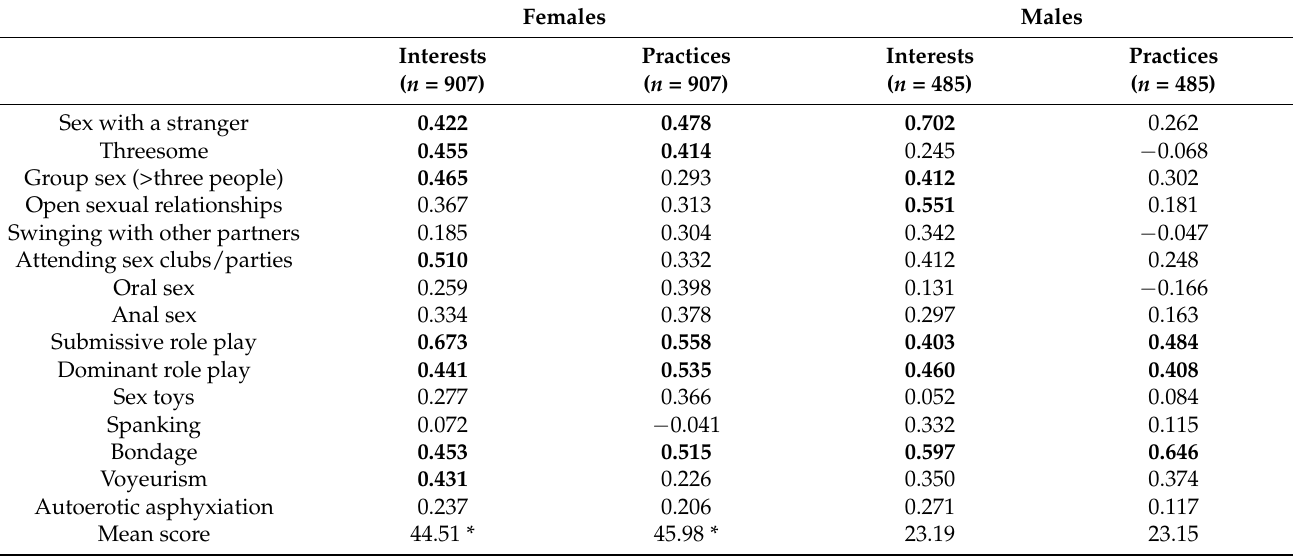
Table 11. Discriminant functional analysis (structure matrix) of the differences between sexual interests and practices for ADHD and Other participants ( n =